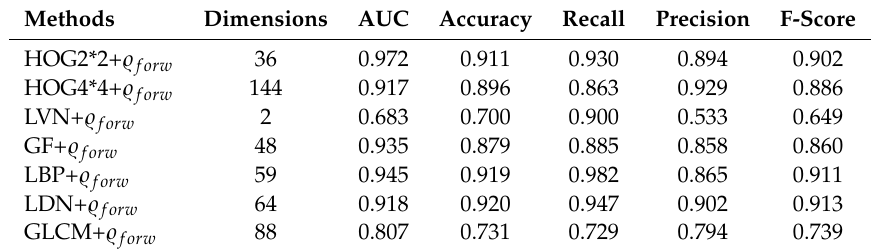
Table 4. The performance of the proposed method when using the representation learned by the forward LTR.